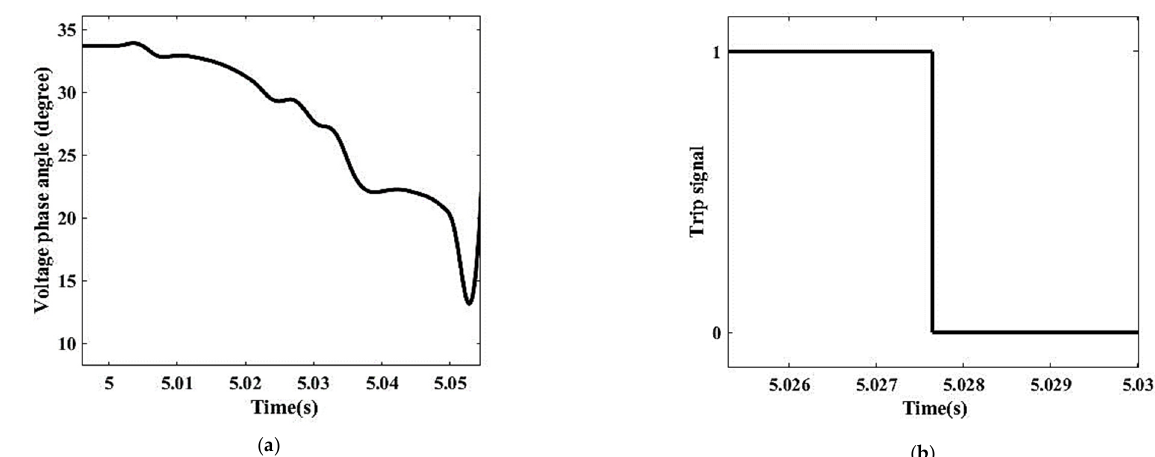
Figure 7. Islanding operation at large power mismatch situation ( a ) magnitude of voltage phase angle magnitude vs. time ( b ) detection time.